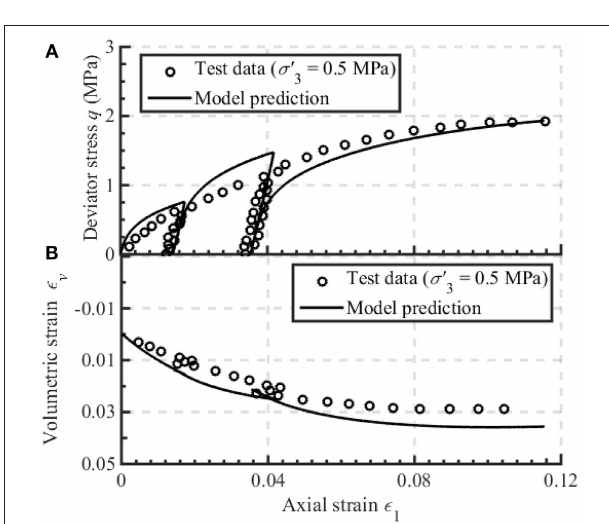
FIGURE 5 | Model prediction of the drained cyclic behavior of Xiaolangdi rockfill (Li, 1988) at low confining pressure: (A) deviator stress vs. axial strain, (B) volumetric strain vs. axial strain.